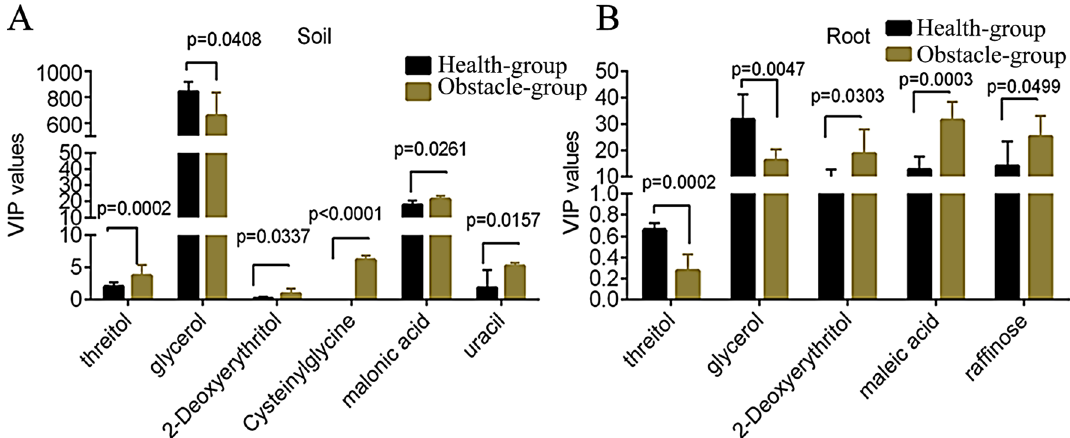
Figure 5. Different metabolites from the soil and root samples between the two groups. Several differential metabolites in soil ( A ) and root ( B ) samples between the two groups, respectively. VIP, variable importance in projection. VIP scores estimate the importance of each variable in the projection used in a PLS model. The p-value is analyzed using a t-test. N/B: the Y axes have been divided into two or three segments for a clearer representation of smaller bars. P values are marked in the figure (n =